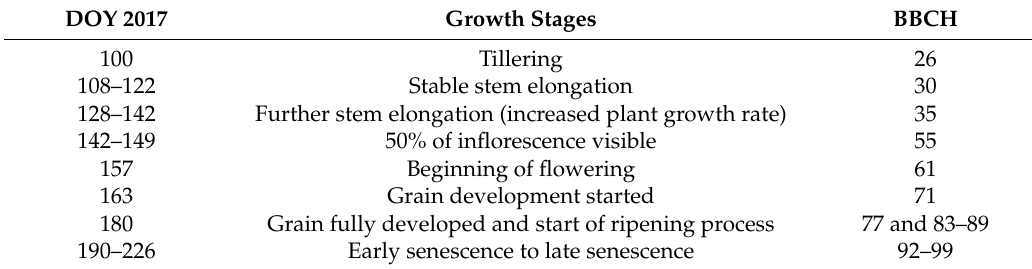
Table 2. Overview of growth stages of the winter wheat between 10th of April (DOY 100) and 14th of August 2017 (DOY 226) and their corresponding BBCH scale